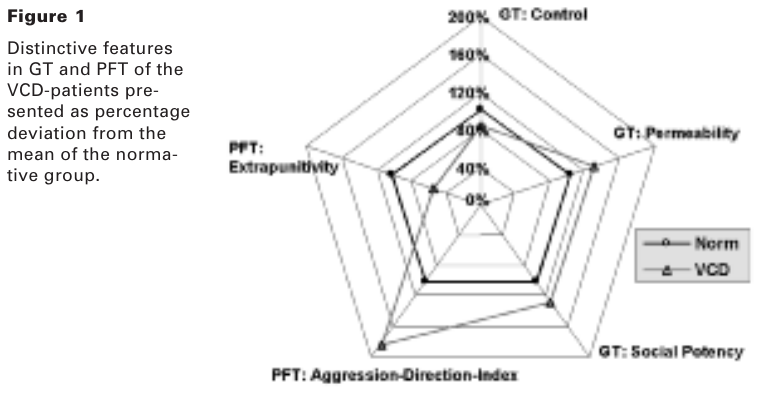
Distinctive features in GT and PFT of the VCD-patients pre- sented as percentage deviation from the mean of the norma- tive